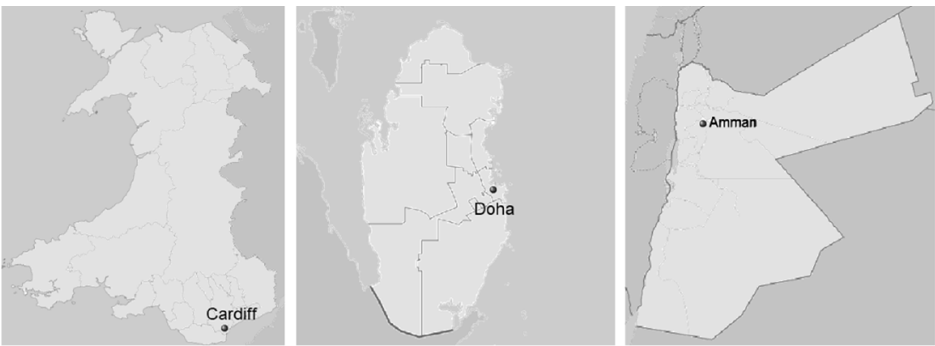
Figure 3. Geographical locations of the three cities we consider (Cardiff, Doha and Amman).